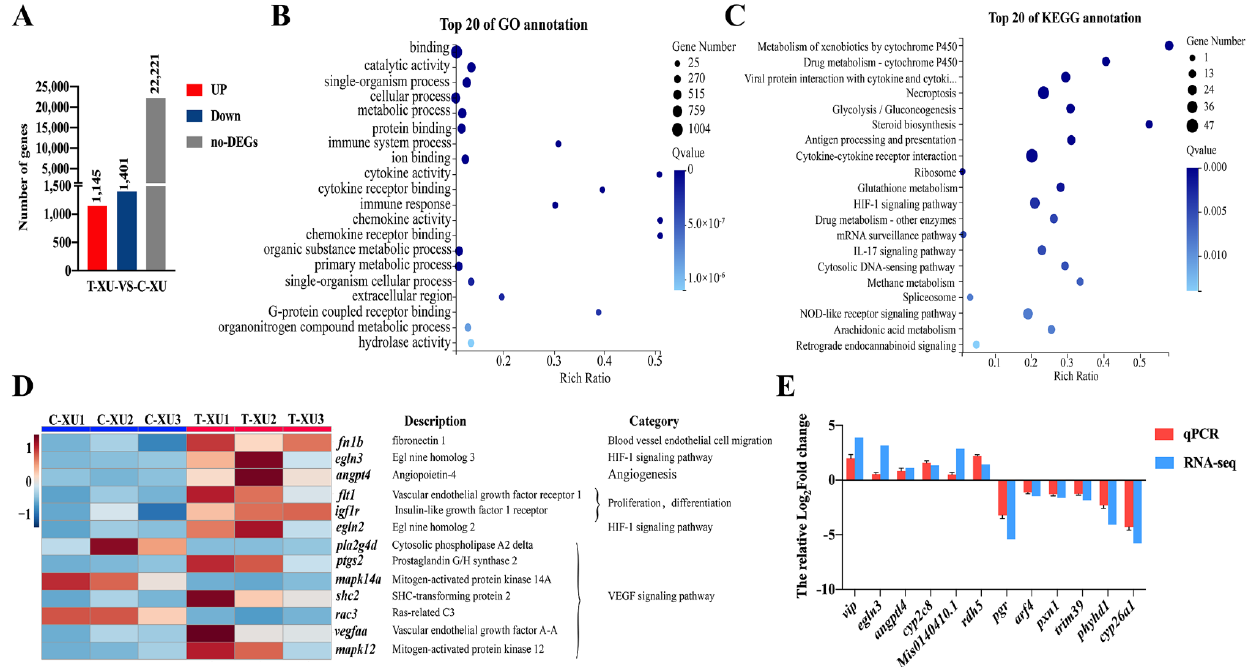
Figure 4. Identification and functional annotations of DEGs in barbels between T-XU and C-XU group (T-XU vs. C-XU). ( A ) Numbers of upregulated, downregulated, and non-DEGs. ( B ) Top 20 GO terms in DEGs. ( C ) Top 20 KEGG pathways in DEGs. ( D ) Heat map of expression levels of 13 key DEGs related to air-breathing. ( E ) qPCR validation of RNA-seq data. DEGs, differentially expressed genes. T-XU and C-XU represent the air exposure group and control group, respectively. qPCR, quantitative PCR. vip , VIP intestinal peptide; egln3 , egl nine homolog 3; angptl4 , angiopoietin-related protein 4; cyp2c8 , cytochrome P450 2C8; rdh5 , 11- cis -retinol dehydrogenase; pgr , progesterone receptor; arf4 , ADP-ribosylation factor 4; pxn1 , pentraxin fusion protein precursor; trim39 , E3 ubiquitin-protein ligase TRIM39; phyhd1 , phytanoyl-CoA dioxygenase domain-containing protein 1; cyp26a1 , cytochrome P450 26A1.